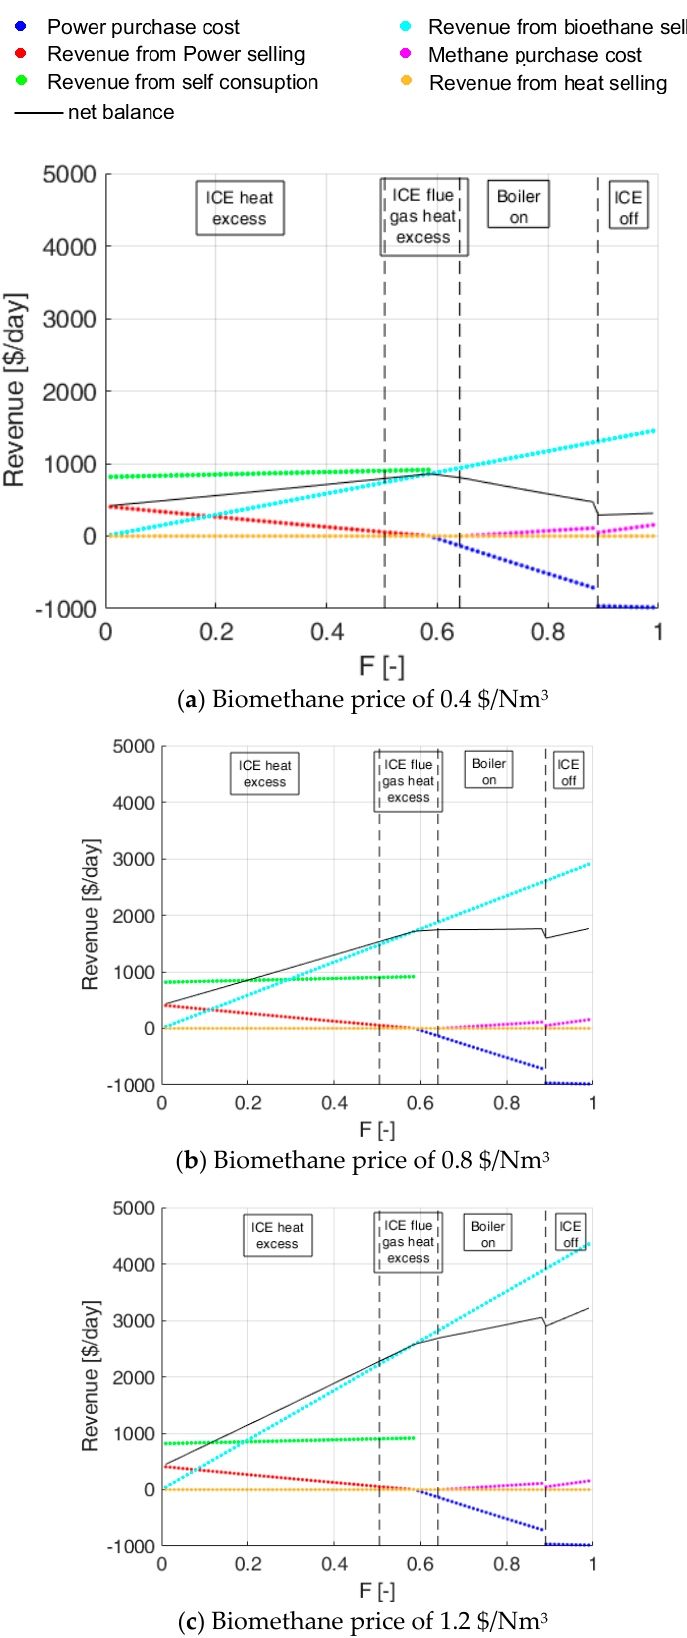
Figure 7. Revenues of the plant when no heat contribution was considered.